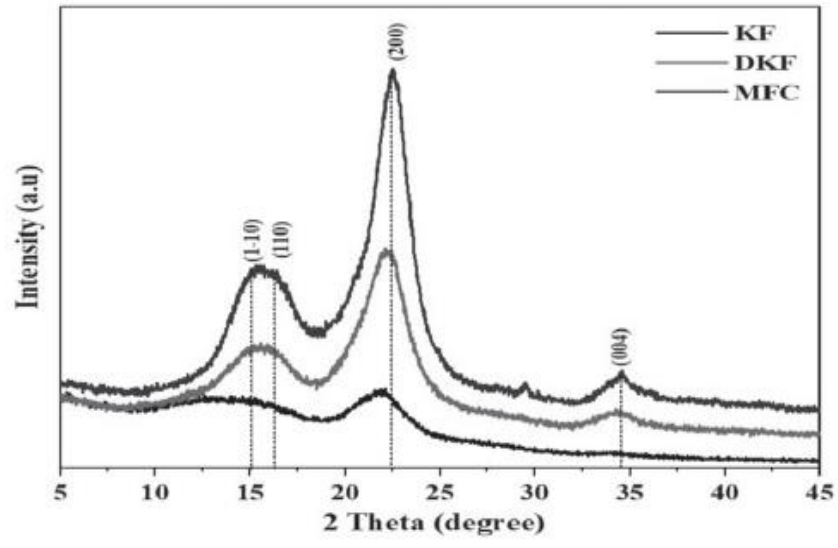
Figure 6. XRD pattern of KF, DKF and MFC [90].